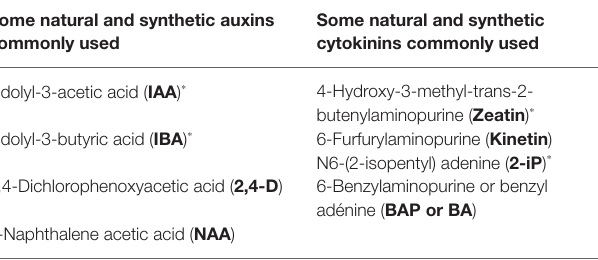
TABLE 1 | Natural and synthetic auxin and cytokinin hormones commonly used in the micropropagation process of plants. Some natural and synthetic auxins commonly used